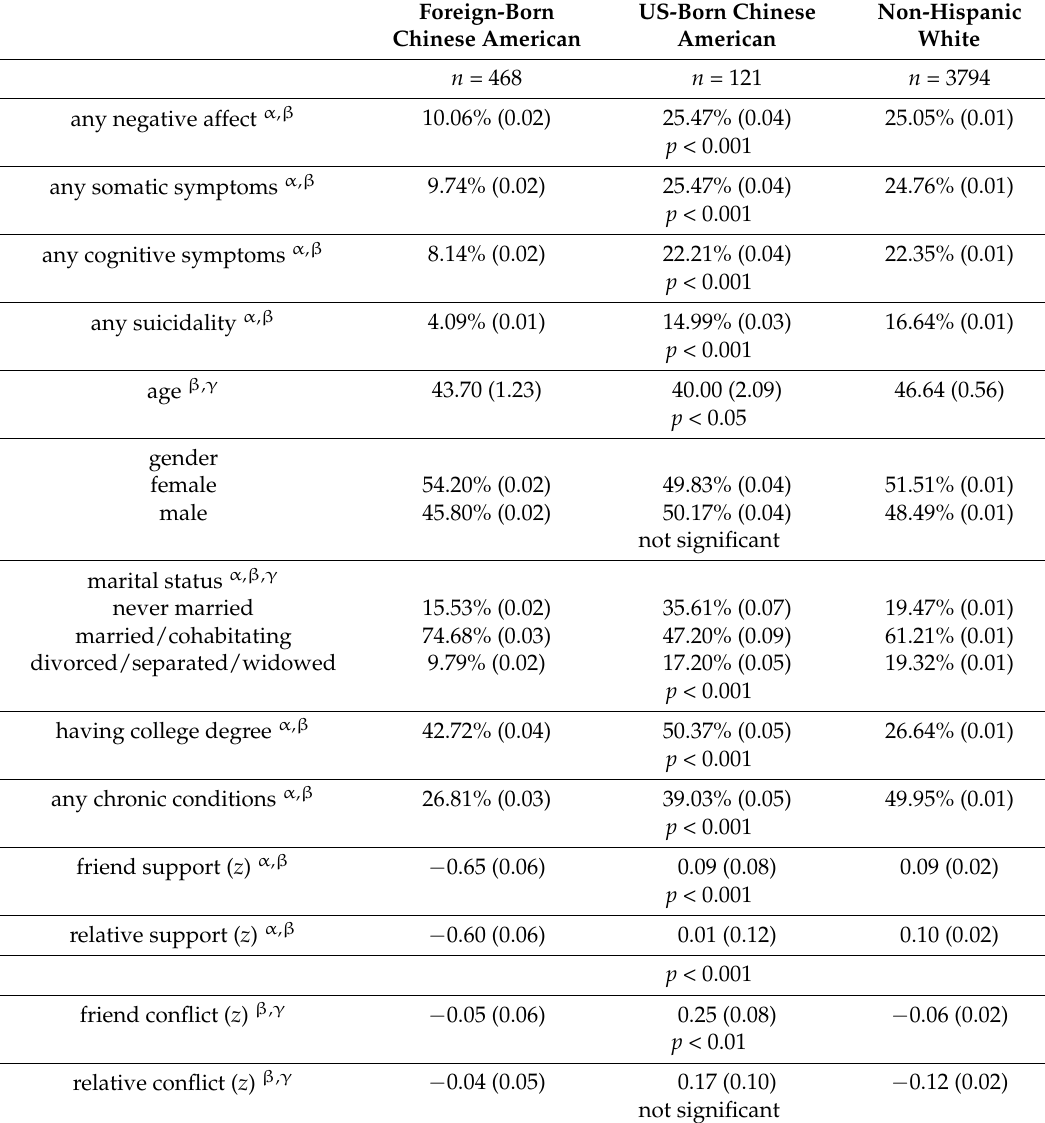
Table 5. Weighted Descriptive Statistics of Sociodemographic